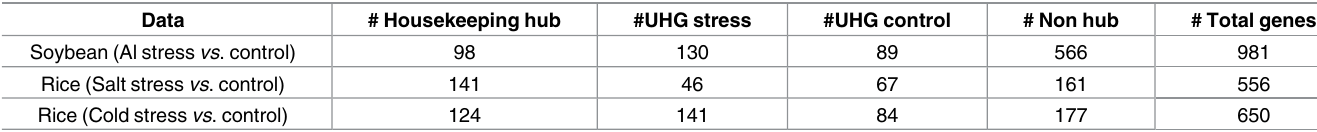
Table 6. Groups of hub genes predicted using DHGA approach.